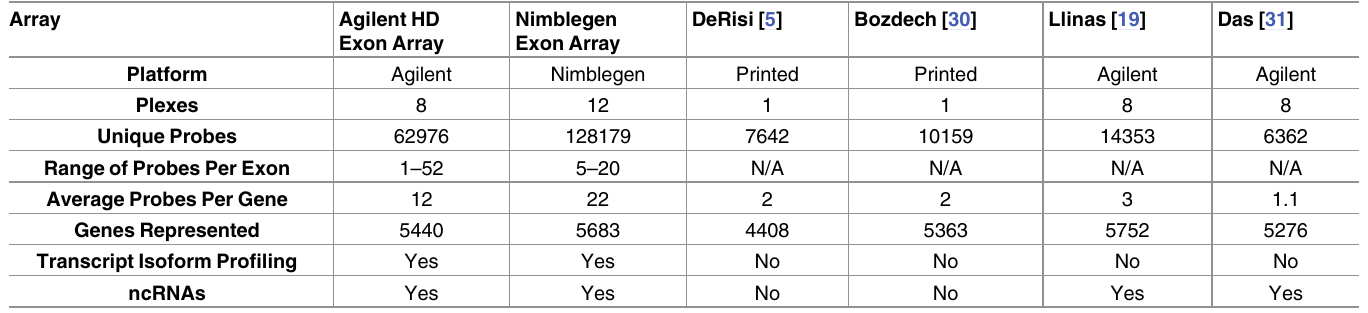
Table 1. Exon array